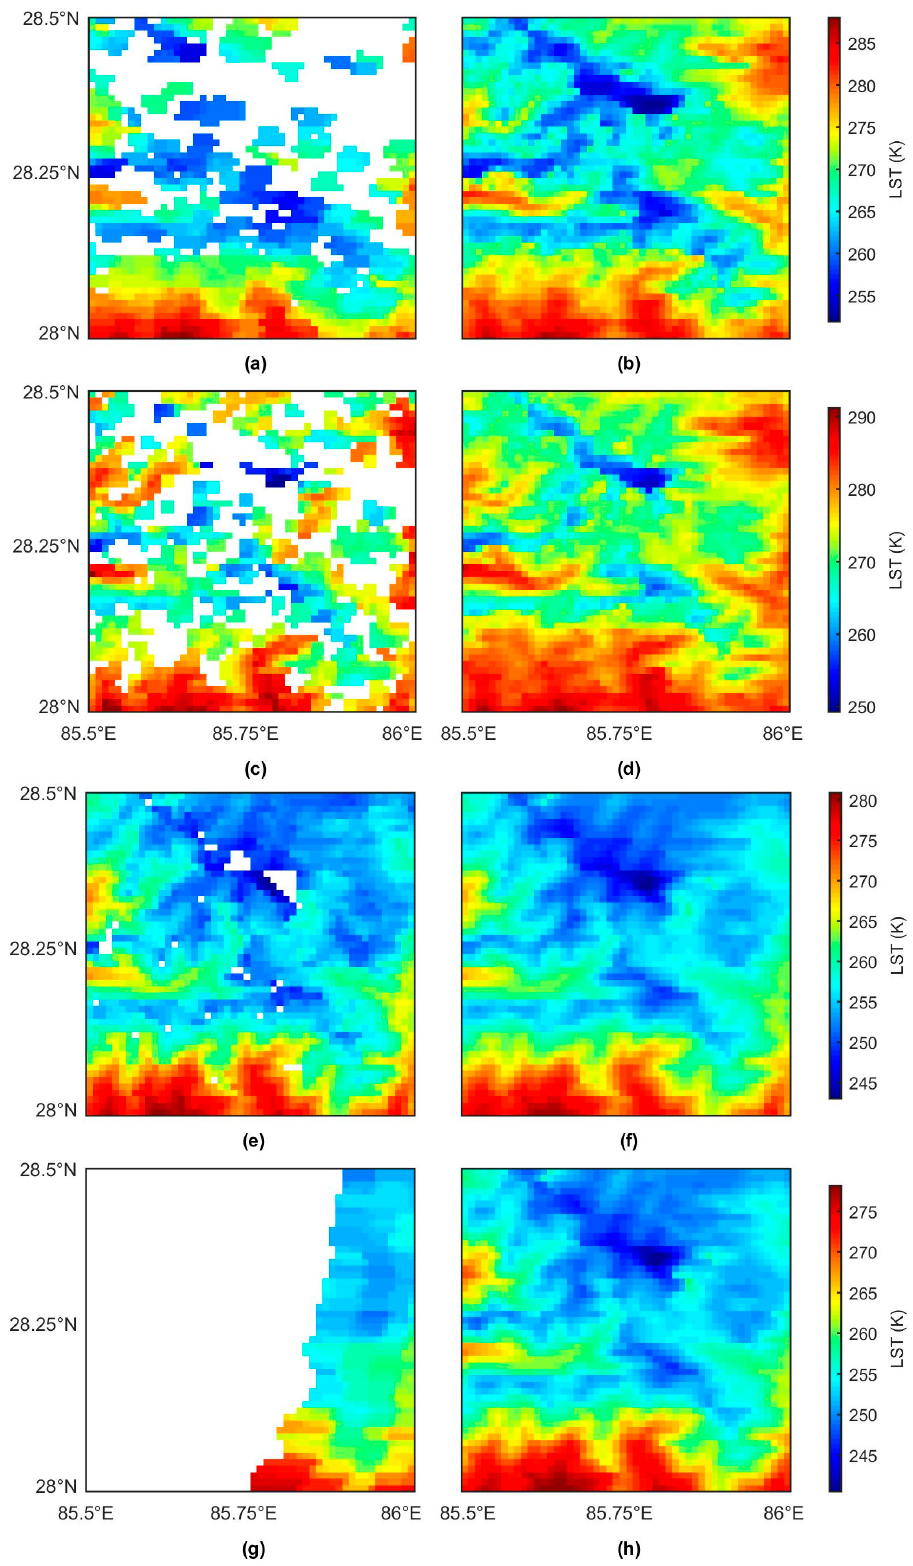
Figure 5. Spatial distribution patterns of LST before and after reconstruction on 19 February 2012 obtained from: ( a ) original MOD11A1 at daytime; ( b ) reconstructed MOD11A1 at daytime; ( c ) original MYD11A1 at daytime; ( d ) reconstructed MYD11A1 at daytime; ( e ) original MOD11A1 at nighttime; ( f ) reconstructed MOD11A1 at nighttime; ( g ) original MYD11A1at nighttime; and ( h ) reconstructed MYD11A1 at nighttime.